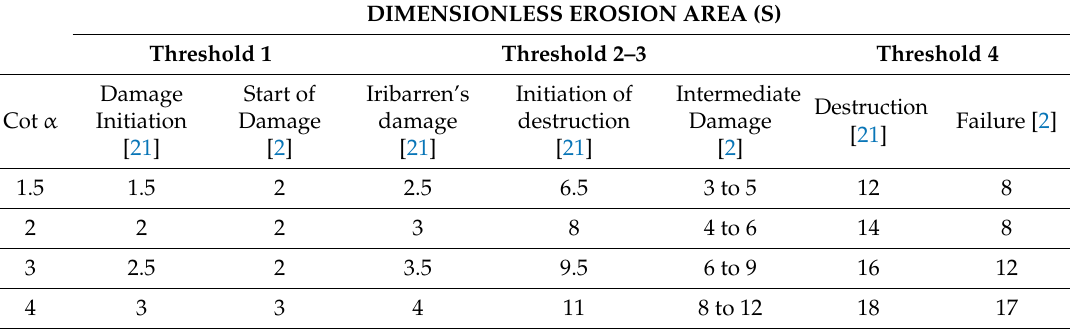
Table 1. Thresholds of S for di ff erent damage levels for non-overtopped two layers conventional breakwaters according to Vidal et al. [21] and the Rock Manual